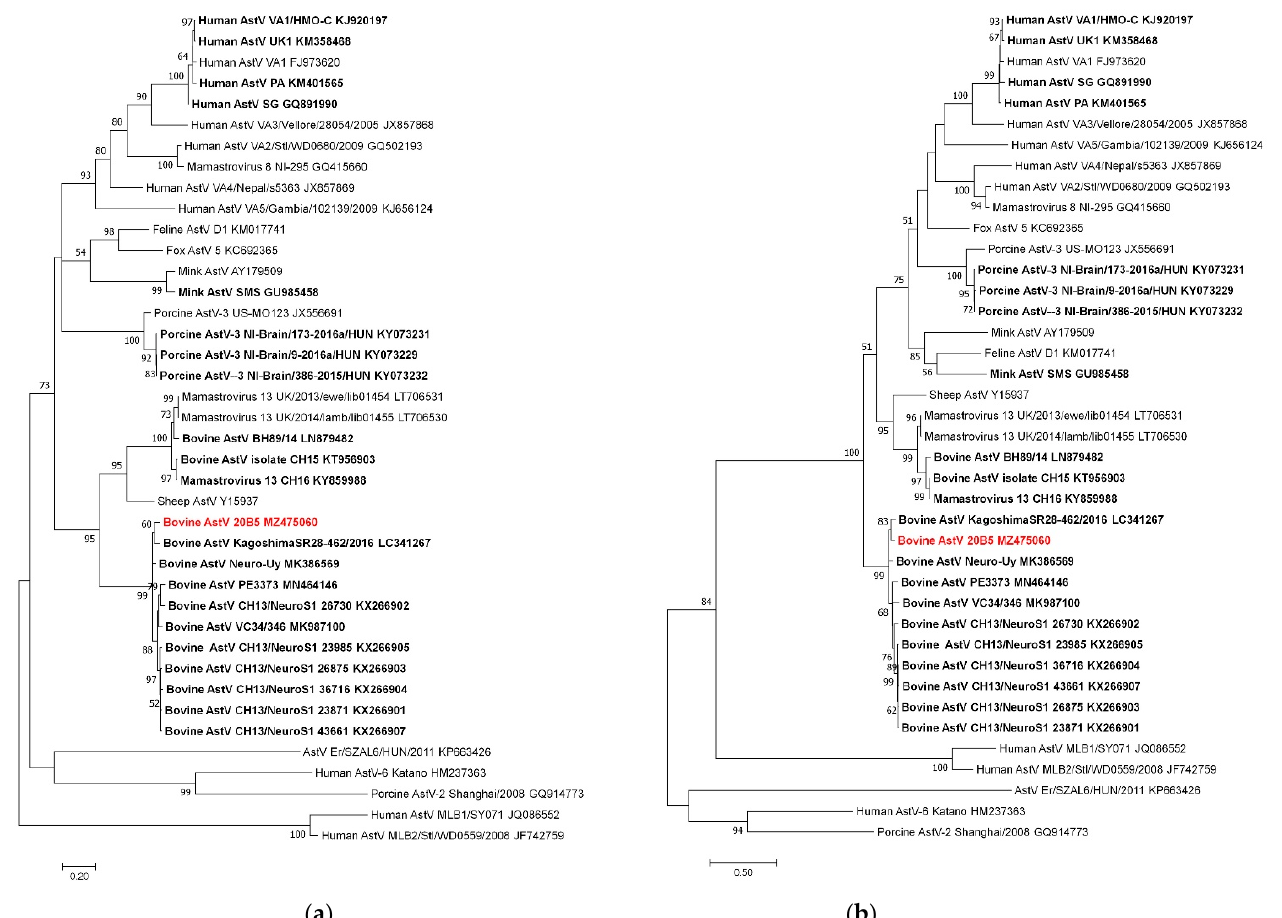
Figure 2. Phylogenetic analysis using ORF1 and ORF2 sequences of bovine astrovirus 20B05: ( a ) Maximum likelihood (ML) tree of ORF1 region (2274–2632 nt; 359 bp); ( b ) ML tree of ORF2 region (4157–5370 nt; 1214 bp). Neurotropic astrovirus strains are indicated in bold letters, and Korean bovine astrovirus is written in red.